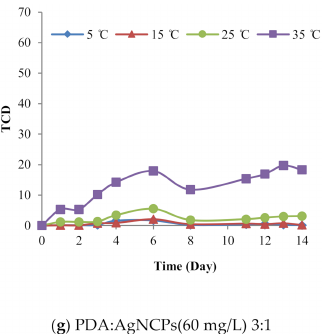
Figure2. E ff ectoftemperatures(5, 15, 25, and35 ◦ C)onchangesintotalcolordi ff erence(TCD)atdi ff erent polydiacetylene:silver nanoparticle (PDA:AgNP) ratios (as % of solid) and AgNP concentrations (30 and 60 mg / L): ( a ) PDA alone, ( b ) 1:3 PDA:AgNPs (30 mg / L AgNPs), ( c ) 2:2 PDA:AgNPs (30 mg / L AgNPs), ( d ) 3:1 PDA:AgNPs (30 mg / L AgNPs), ( e ) 1:3 PDA:AgNPs (60 mg / L AgNPs), ( f ) 2:2 PDA:AgNPs (60 mg / L AgNPs), and ( g ) 3:1 PDA:AgNPs (60 mg / L AgNPs) embedded in CMC:PDA / AgNPs at 75:25.